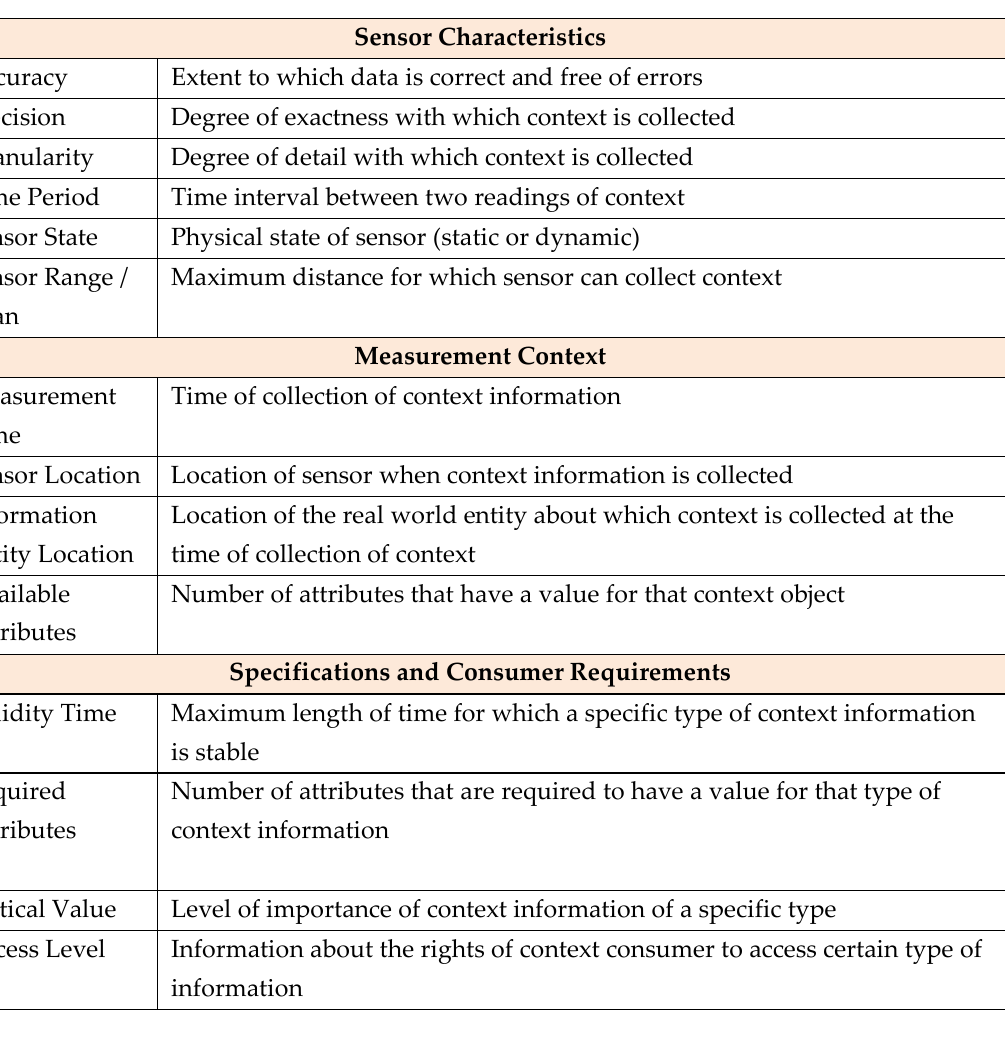
Table 3. A summary of QoC metrics and calculation methods